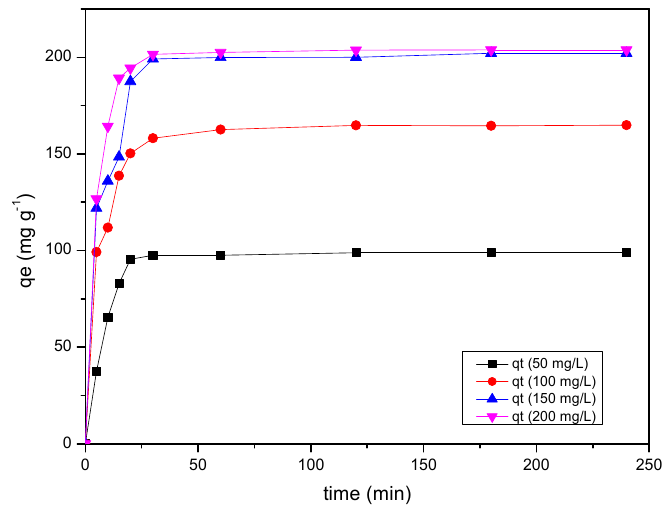
Figure 5. Effect of adsorption on contact time and initial concentration of MB dye by RF/TiO 2 gel.